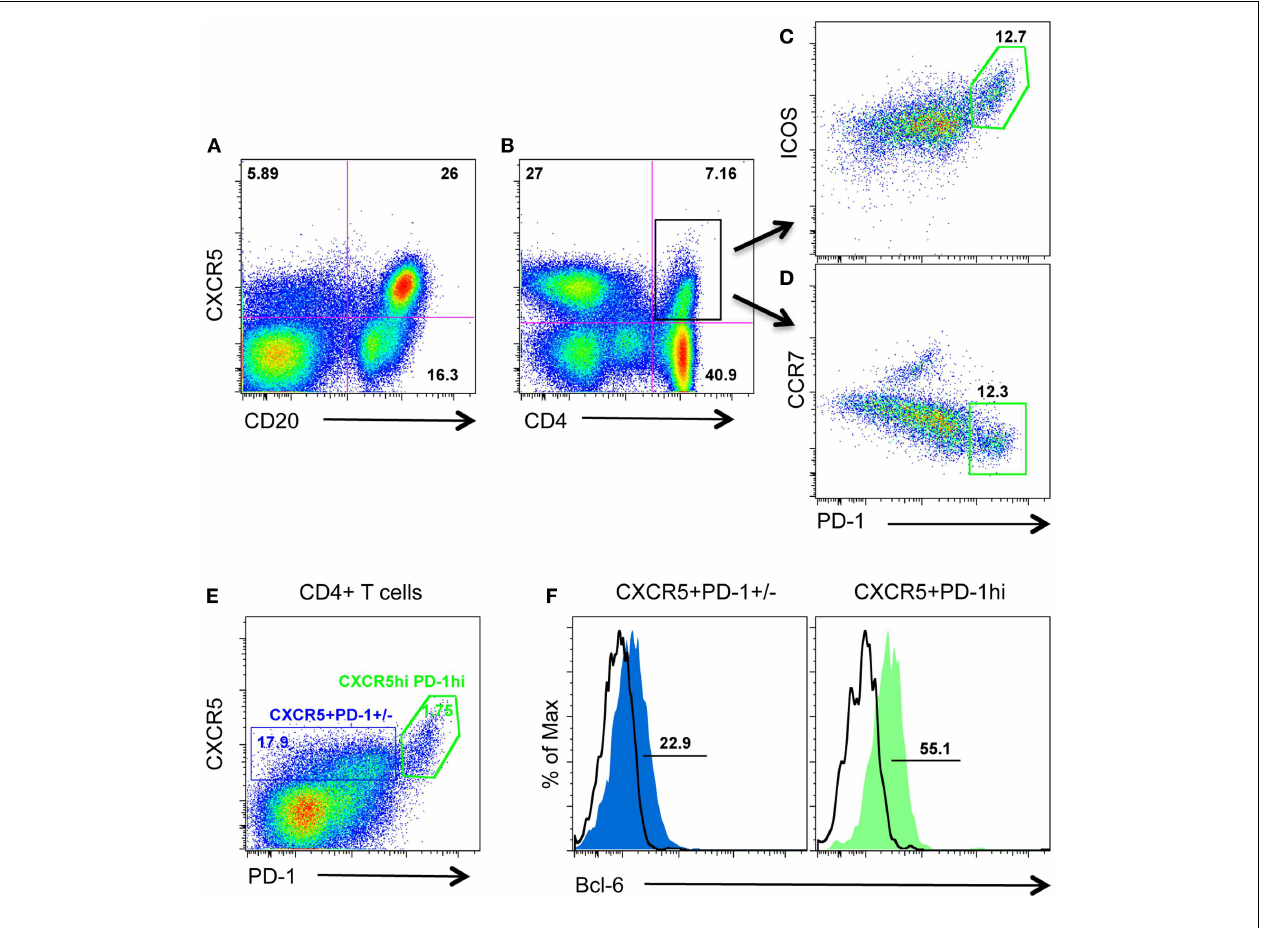
CCR7 expression on CXCR5 + CD4 + T cells/TFH cells from lymph nodes; (E) CXCR5 + CD4T cells contain both PD-1 INT and PD-1 HIGH cell populations; (F) transcriptional factor Bcl-6 expression in CXCR5 + PD-1 INT and CXCR5 + PD-1 HIGH CD4T cell subsets.